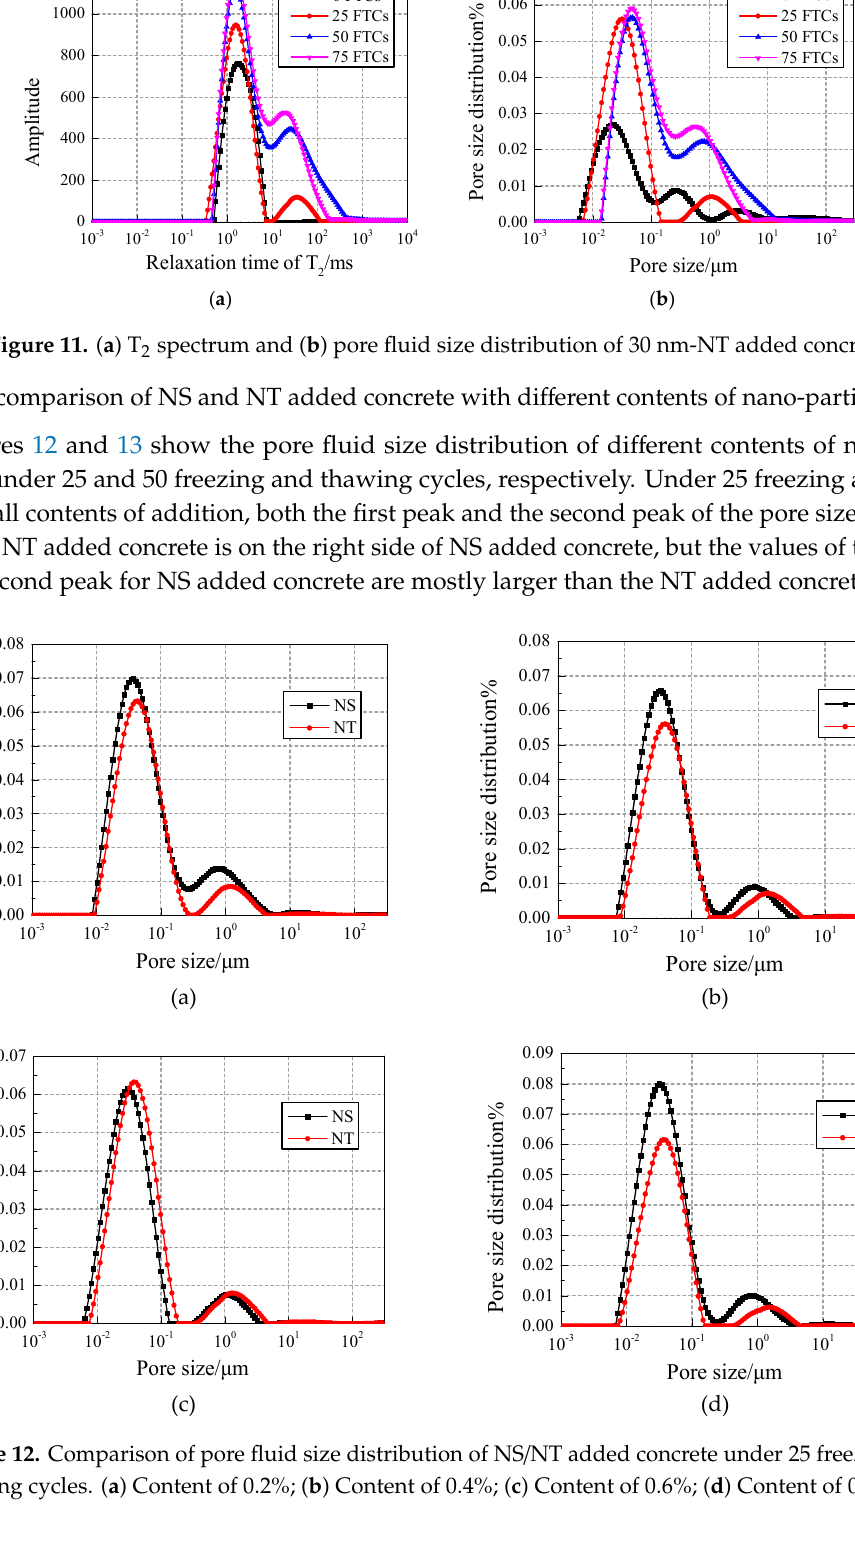
Figure 10. ( a ) T 2 spectrum and ( b ) pore fluid size distribution of 30 nm-NS added concrete.